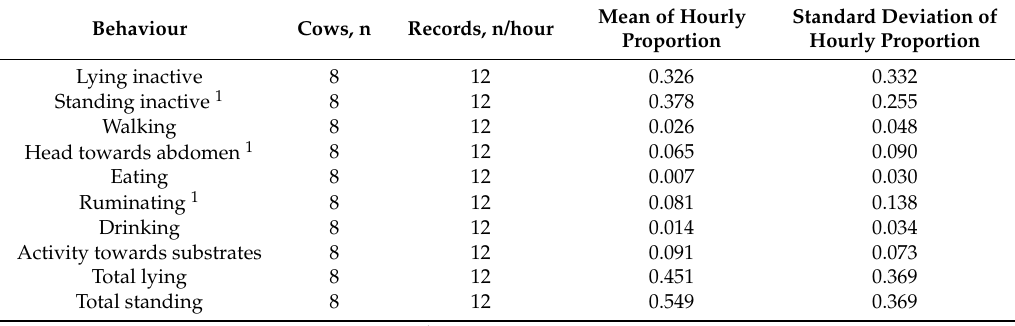
Table 2. Descriptive statistics of proportions of total records for hour relative